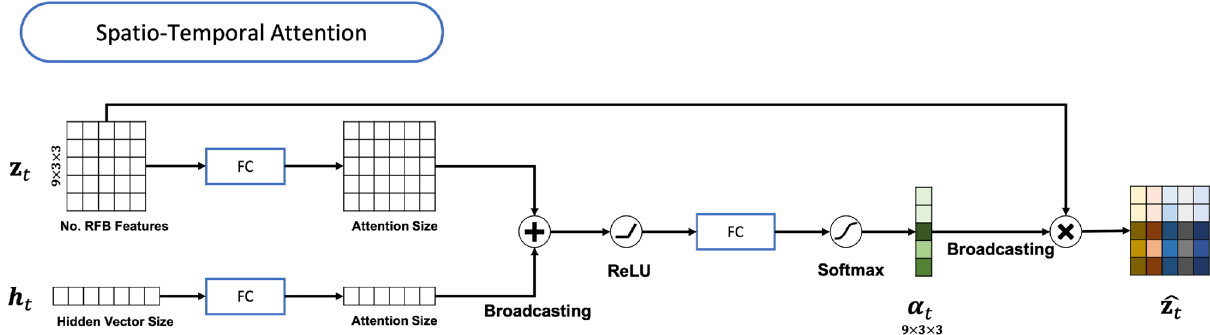
Figure 11. Structure of the trainable attention Module. “FC” and “Broadcasting” denote a fully-connected layer and implicit copying of vector,